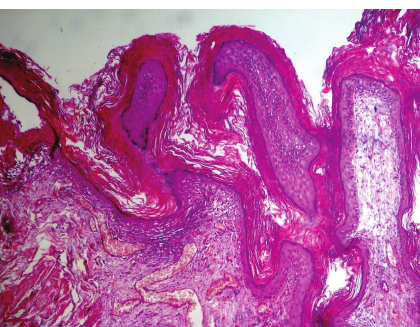
Figure 3: Immunohistochemically, the nuclei of the tumor cells were positive to p63 (DAB/Hematoxylin, ×